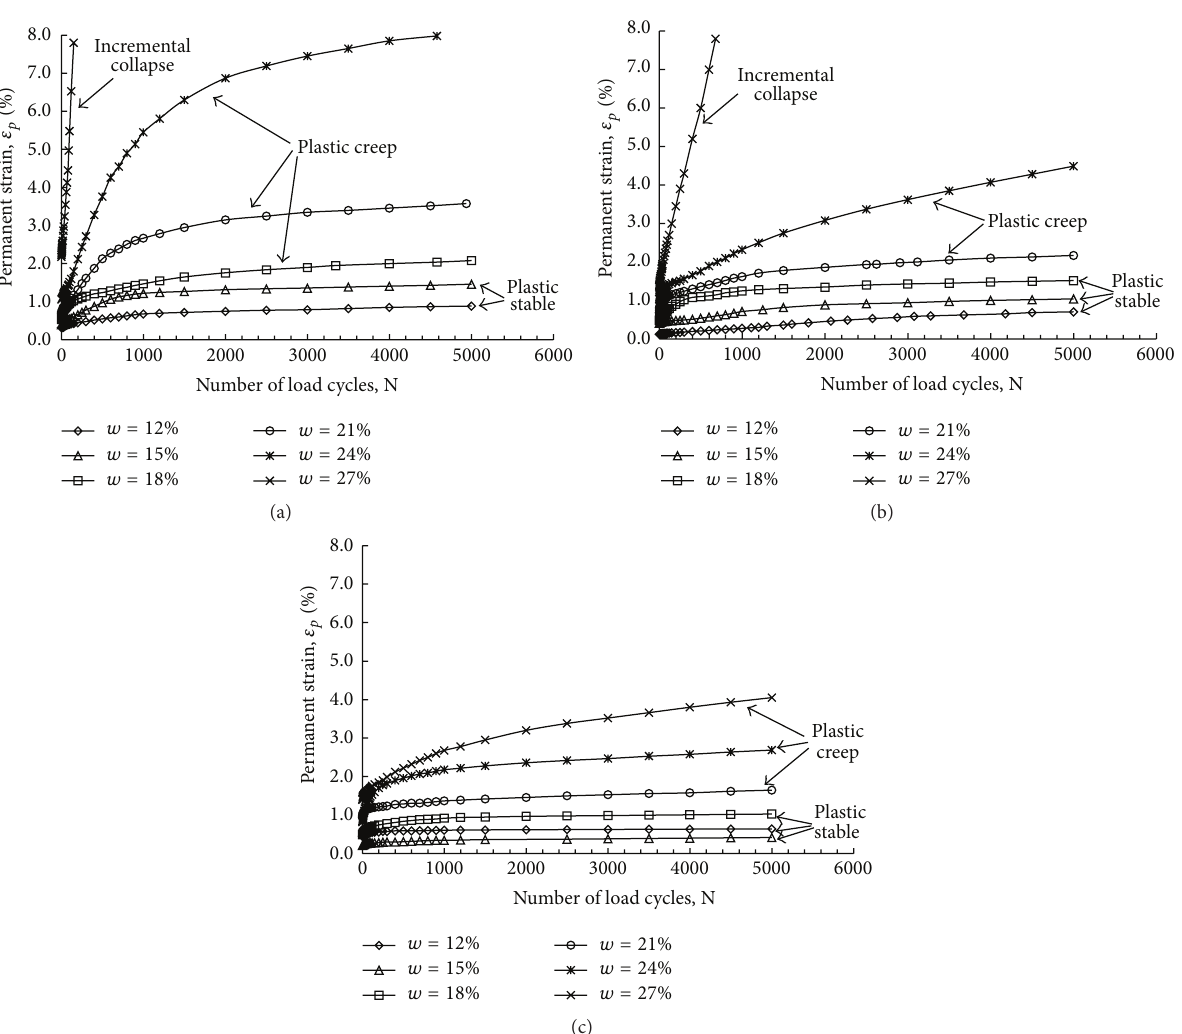
and low deviator stress. In contrast, for the cases with high moisture content and high deviator stress, the permanent strain rate decreases very slowly or keeps constant, which causes progressive accumulation of permanent strain and may eventually lead to unstable or failure state. Furthermore, both permanent strain rate and permanent strain decrease